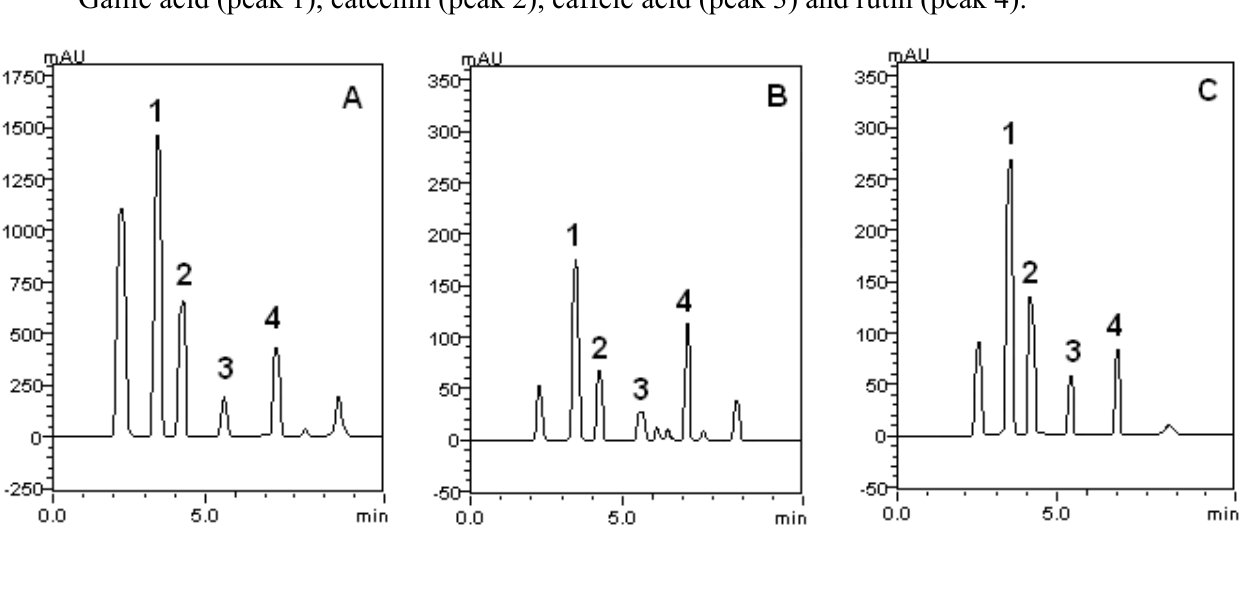
Figure 1. High performance liquid chromatography profile of S. rotundifolium : ( A ): hydroalcoholic bark extract; ( B ): aqueous leaves extract; ( C ): aqueous bark extract.